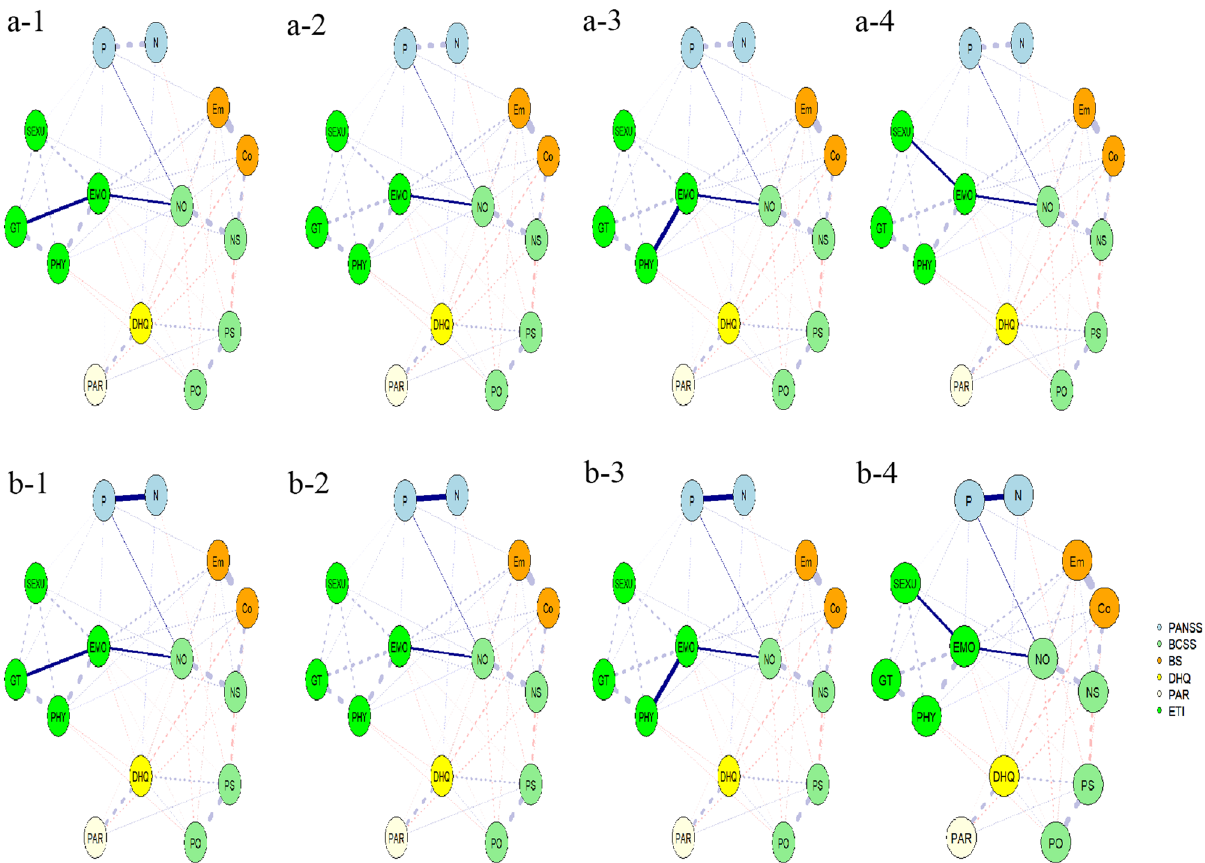
Figure 4. Shortest pathways from GT, EMO, PHY or SEXU to P ( a-1 , a-2 , a-3 and a-4 ) or N ( b-1 , b-2 , b-3 and b-4 ) in patients. Thicker solid lines represent stronger connections; Dashed lines represent background connections existent within the network that are less relevant when investigating shortest paths. Abbreviation: same as in the Fig. 1. The R-packages ‘networktools (version 1.4.0 and URL https:// CRAN.R- proje ct. org/ packa ge= netwo rktoo ls)’ and ‘igraph (version 1.2.7 and URL https:// CRAN.R- proje ct. org/ packa ge= igraph)’ were used.